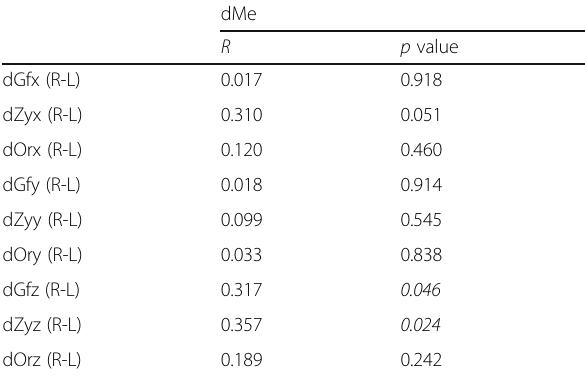
Table 7 The correlation between chin deviation and difference between the measurements of distances in paired upper and middle facial third structures ( N =